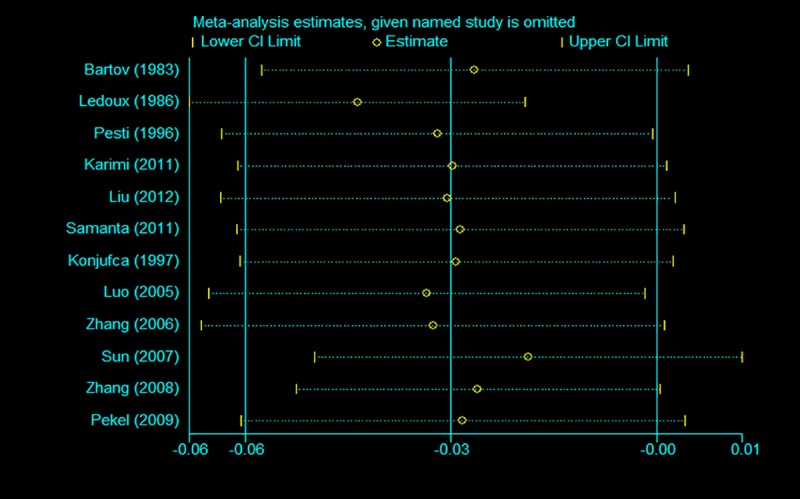
Sensitivity analysis of FCR.